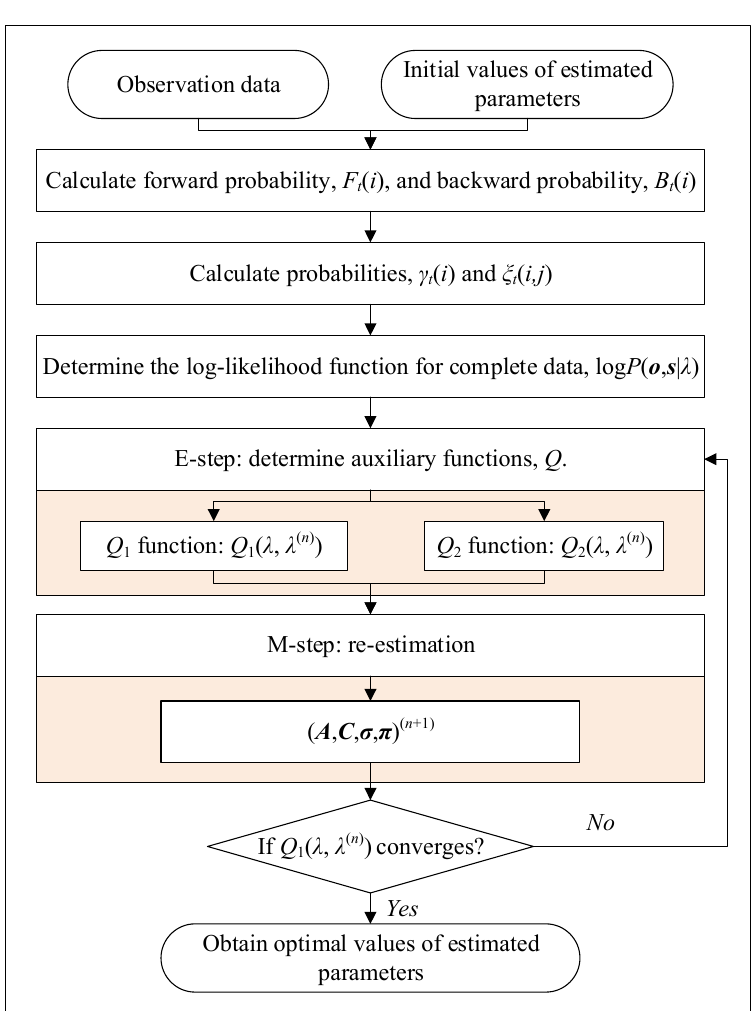
Figure 3. The flowchart of the improved EM algorithm.